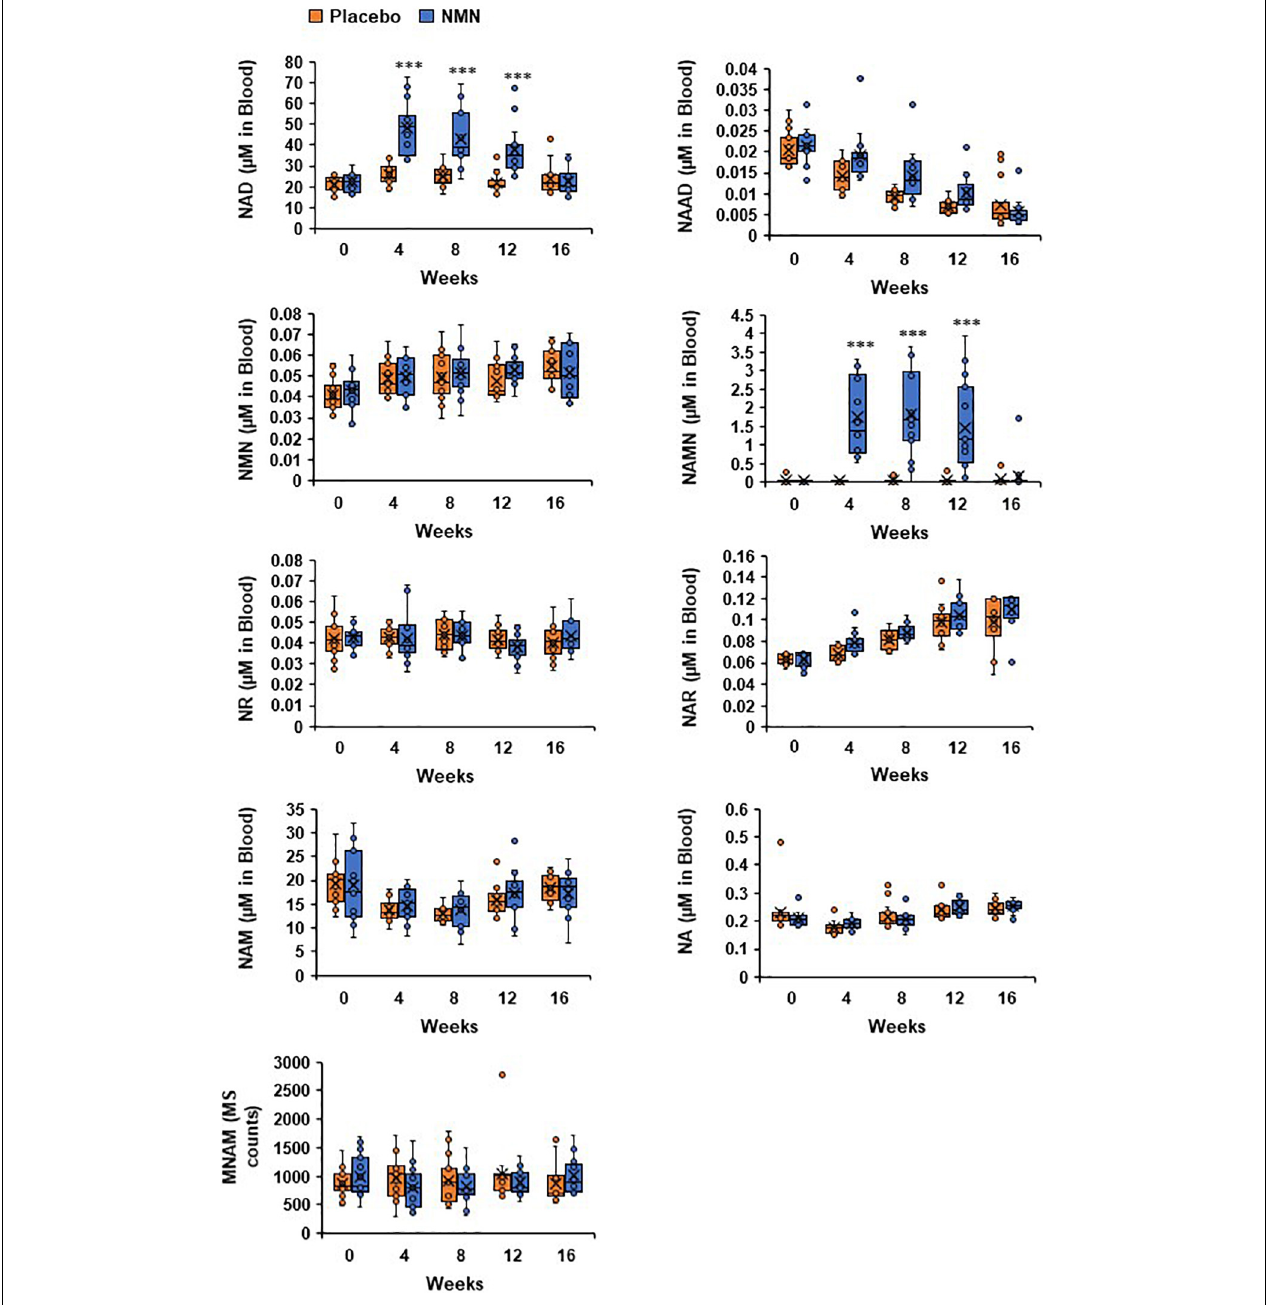
FIGURE 6 | Levels of NAD + and NAMN in blood were increased by oral administration of NMN. NAD metabolome in blood was measured every 4 weeks. NAD metabolome in each time point was showed in box plots. In the box plots, the median is indicated by the line within the boxes. The lower and upper boundaries of the boxes indicated 25th and 75th percentiles. The upper and lower lines above and below the boxes represent the whiskers. Orange boxes represent placebo group ( n = 15 at 0, 4, 8 weeks, n = 14 at 12, 16 weeks) and blue boxes represents NMN group ( n = 15). Levels of MNAM were calculated by integrating peak area of each chromatogram (MS counts). Three asterisks mean statistical significance: p -value <